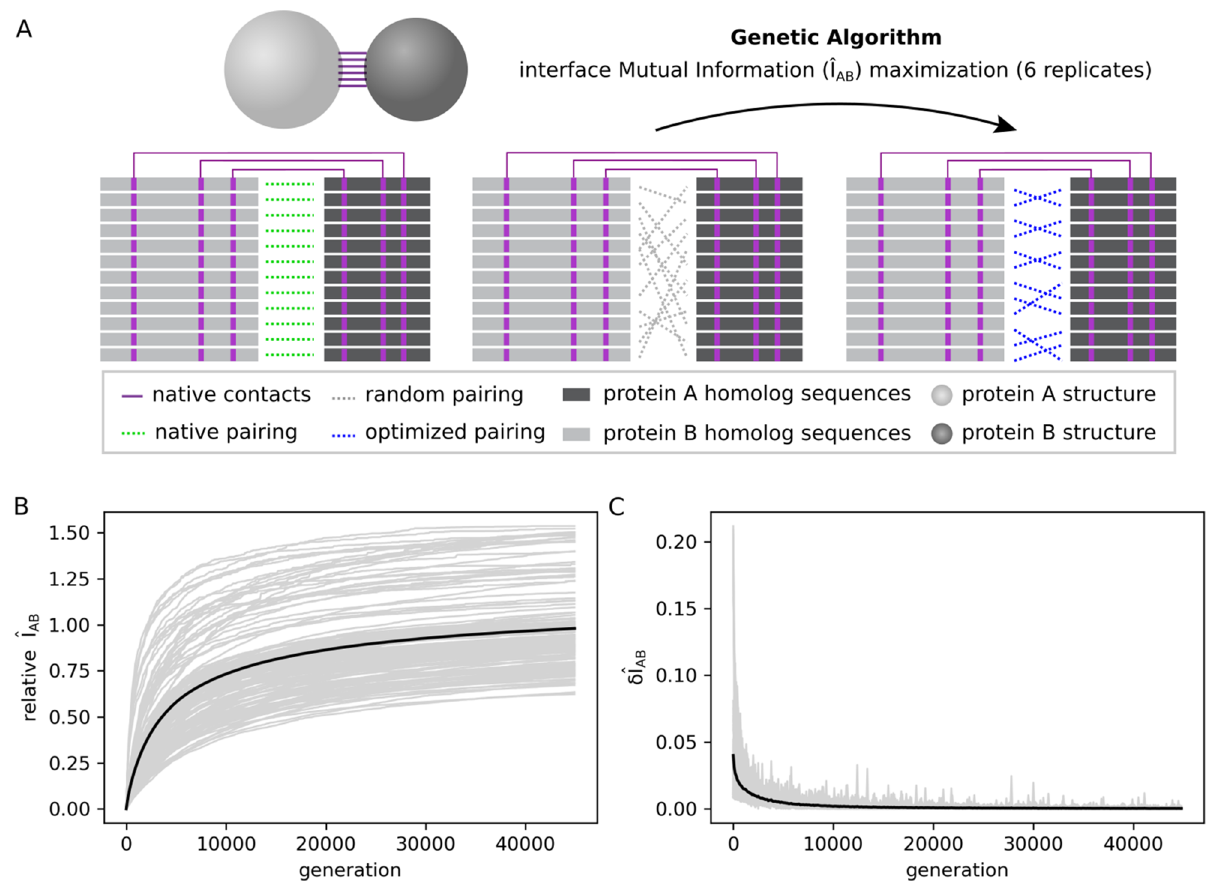
Figure 2. Interface mutual information ( ˆ I AB ) optimization trajectories. ( A ) Scheme showing ˆ I AB optimization process starting from a scrambled multi-sequence alignment (MSA) concatenation (in gray) and reaching an optimized concatenation (in blue). Only physically coupled MSA position pairs (shown in purple) are taken into account. ( B ) Optimization trajectories for 26 protein systems. For each system, there are six trajectories with different starting points. The ˆ I AB normalized by the native interface mutual information (relative ˆ I AB ) is plotted against the number of generations of the genetic algorithm (gray lines). The average trajectory over all complexes is shown in black. ( C ) First-order derivative of the optimization trajectories shown in ( B ). The derivatives of individual trajectories are shown in gray, while the average derivative over all trajectories is shown in black. This figure was generated with Inkscape (https:// inksc ape. org/) and matplotlib v3.1.2 (https:// matpl otlib.